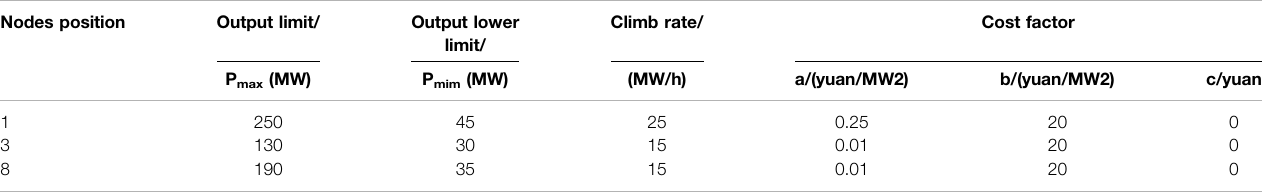
TABLE 1 | Operation parameters of thermal units.